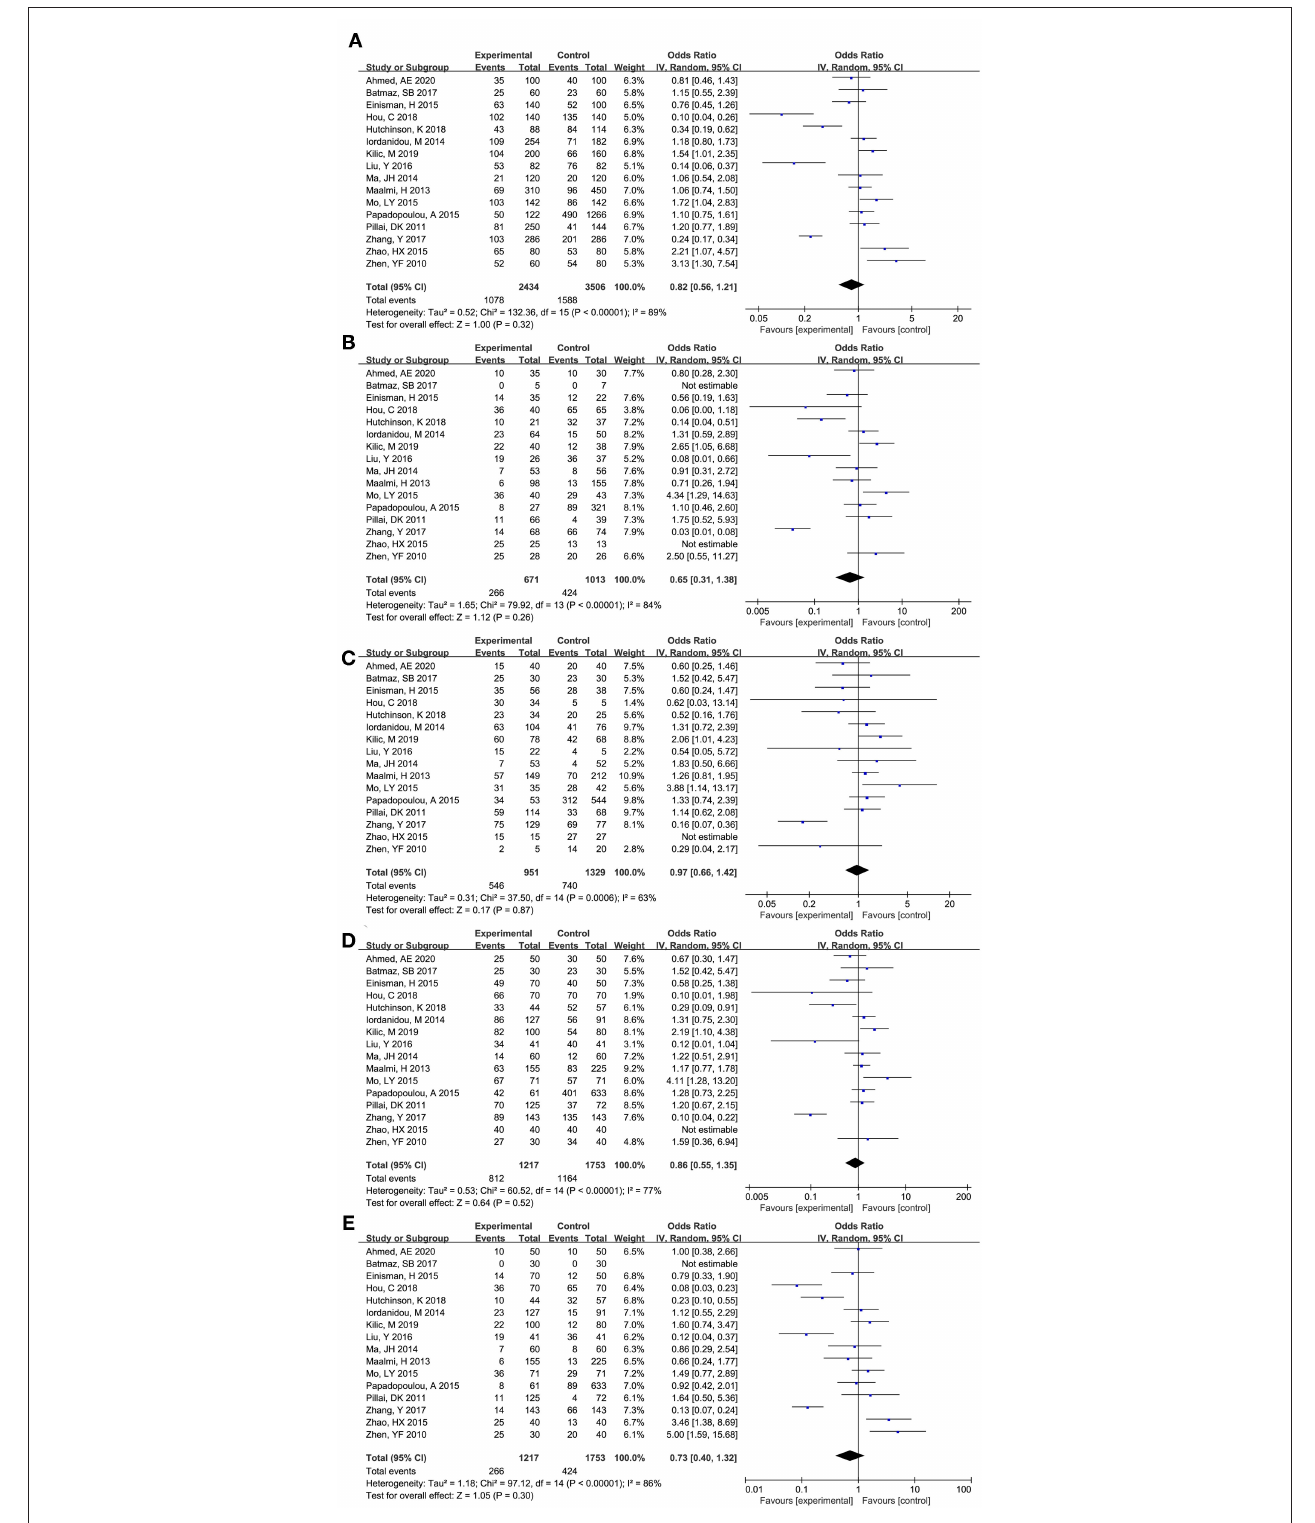
FIGURE 2 | Forest plot for meta-analyzing the association between Vitamin D receptor ApaI (rs7975232) polymorphisms and childhood asthma. (A) additive model: a vs. A; (B) co dominant model: aa vs. AA; (C) co dominant model: Aa vs. AA; (D) dominant model: aa + Aa vs. AA; (E) recessive model: aa vs. AA + Aa.